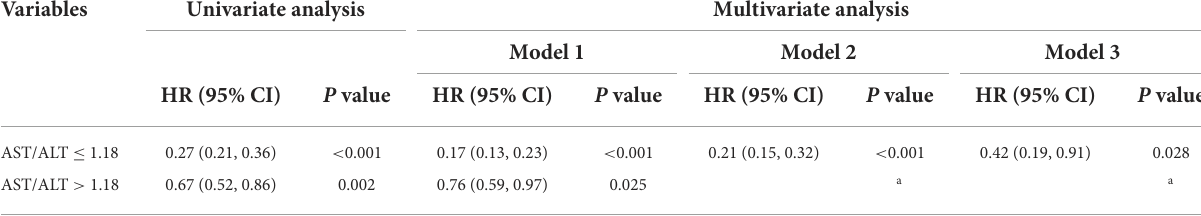
TABLE 3 Association between AST/ALT (DeRitis) ratio and incident diabetes based on restricted cubic spline regressions. Variables